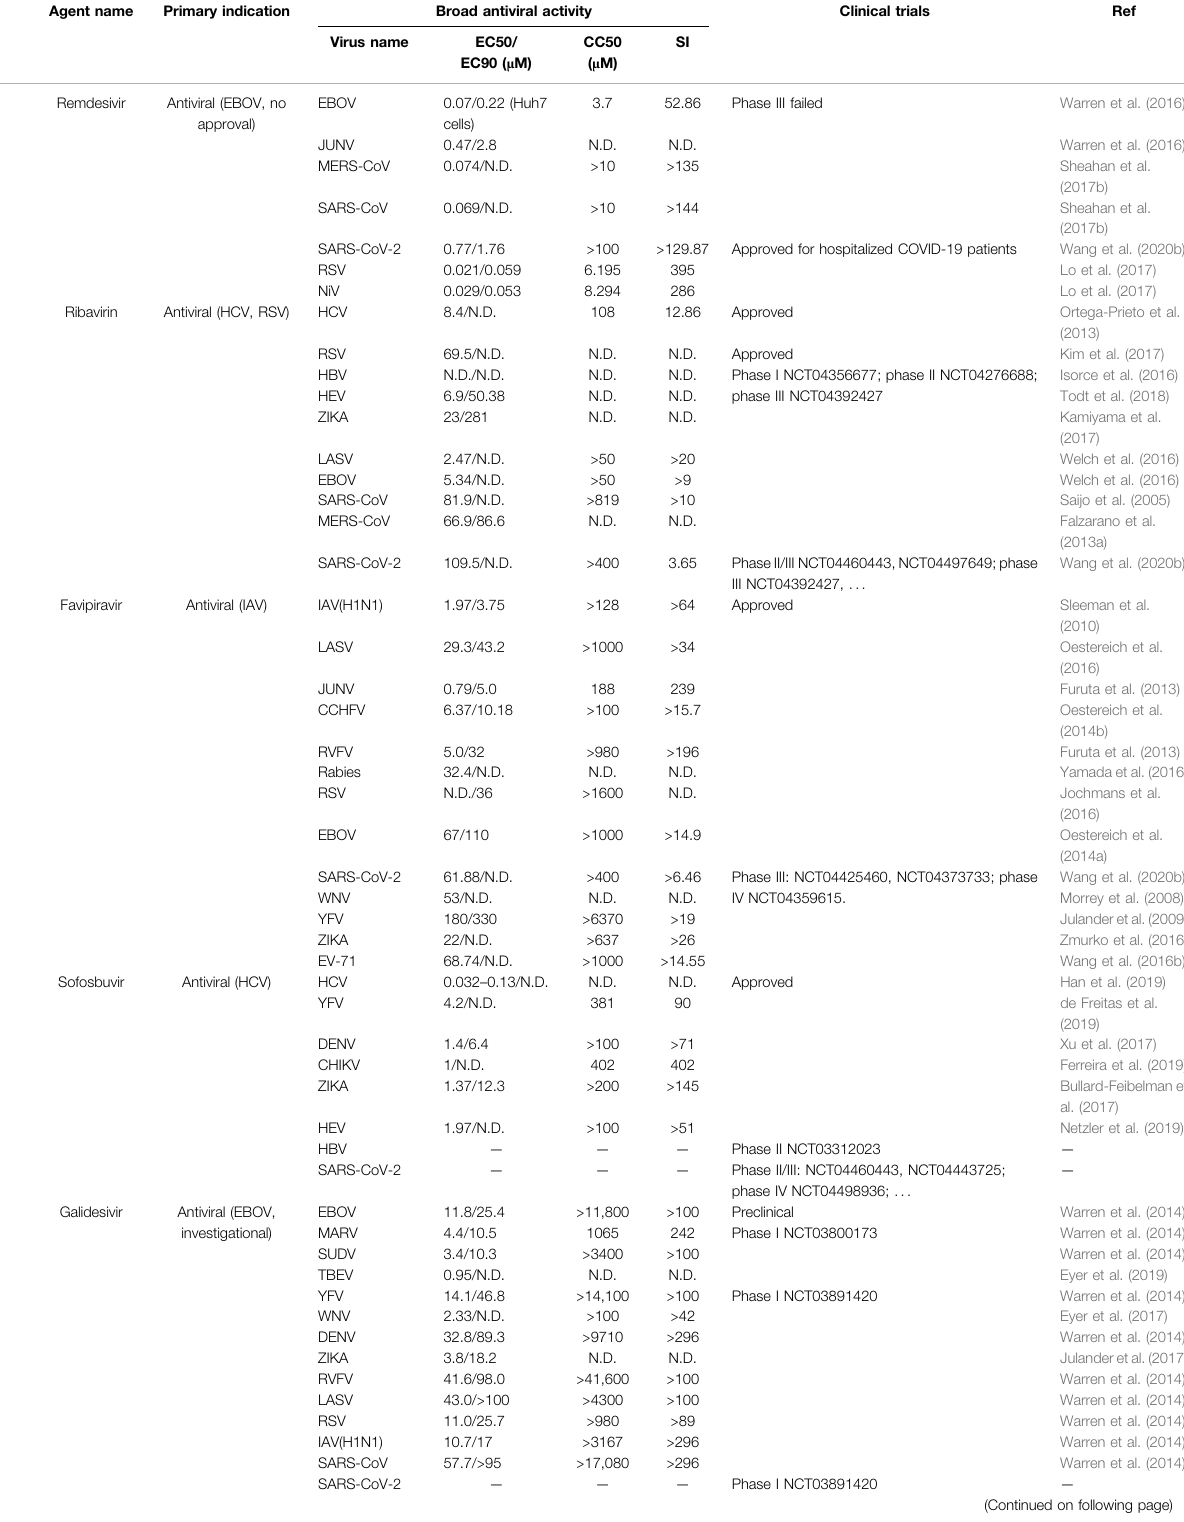
TABLE 3 | Approved or investigational direct-acting antivirals with repurposed potential against other virus infections.